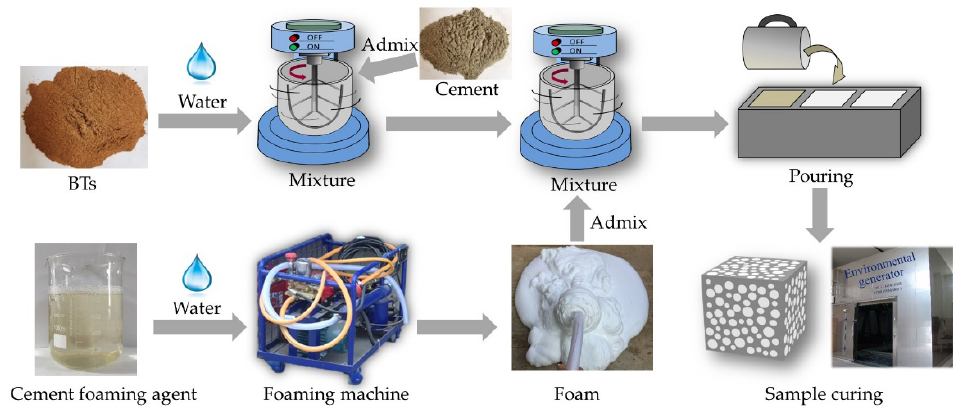
Figure 2. Schematic diagram of the FMLSB preparation process.